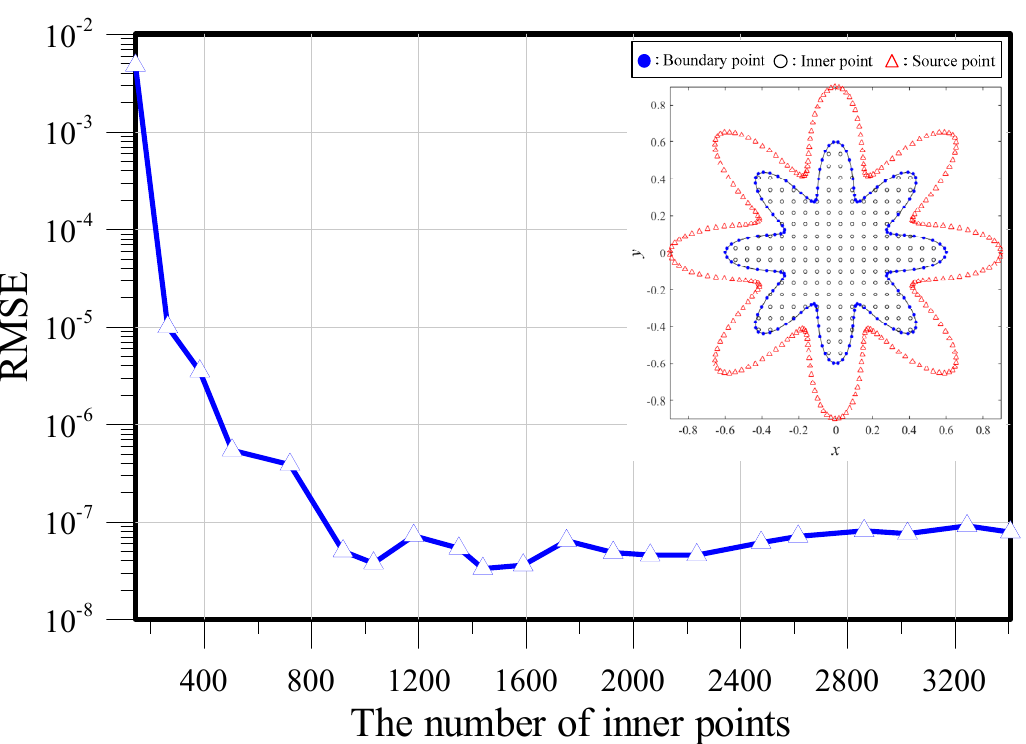
Figure 16. Internal point number versus RMSE.